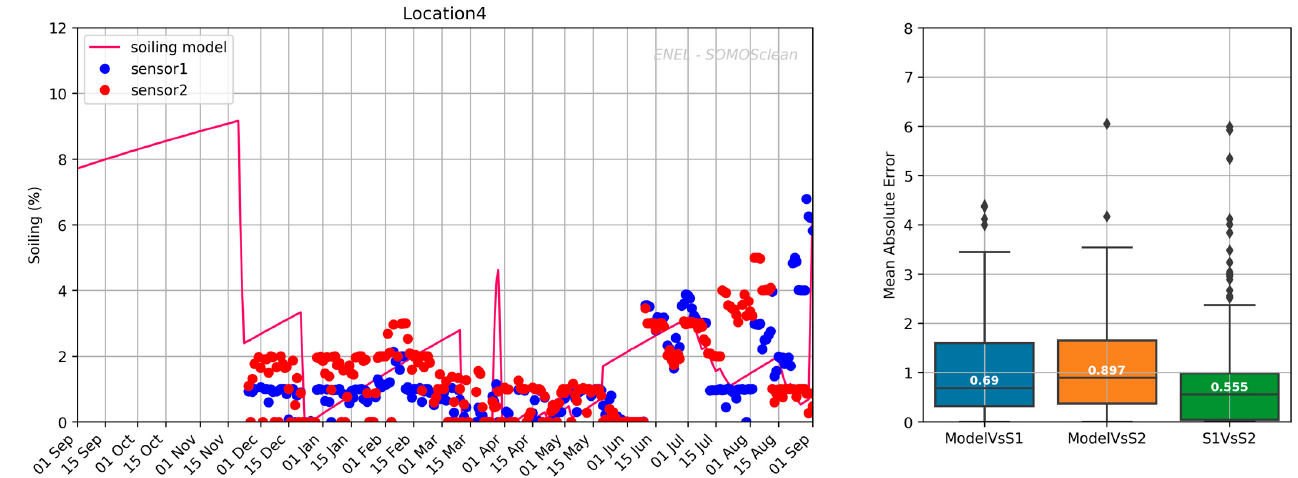
Figure A3. Soiling data from the power plant at location 3.